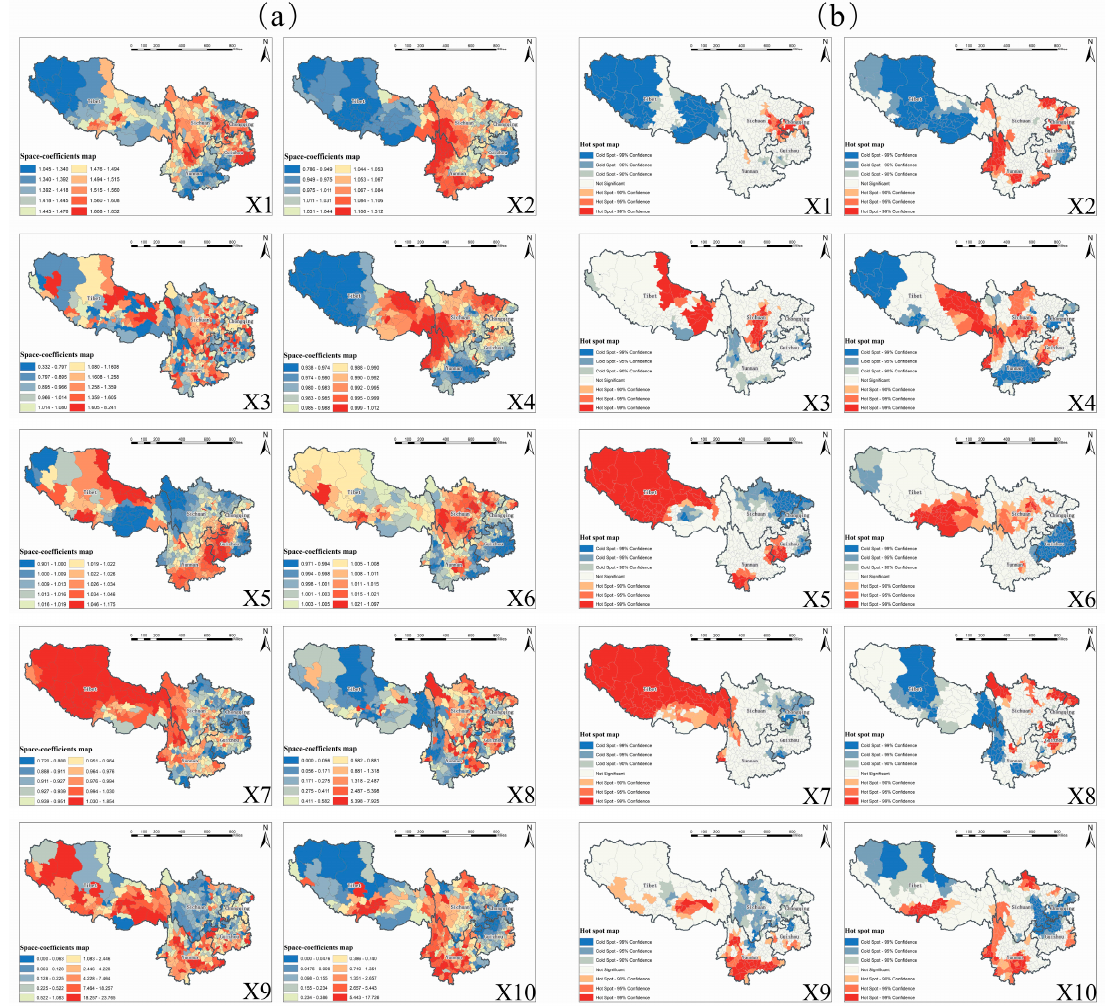
Figure 5. ( a ) Space-coe ffi cient (SC) maps for detecting the spatially heterogeneous hospital bed-covariates relationships of both socioeconomic and environmental factors at the county level across southwest China, and ( b ) SC’s clustered hot spot maps: X1 residents’ saving deposits per capita; X2, total investment in fixed assets per capita; X3, GDP per capita; X4, urban worker population density; X5, total retail sales of consumer goods per capita; X6, nighttime light index; X7, wind speed; X8, river network density; X9, slope; X10, road network